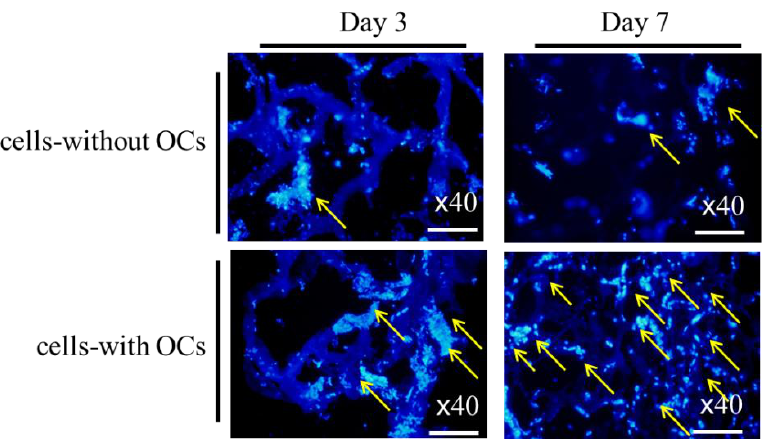
Figure 6. OC-embedded cells were visualized using DAPI staining and 3D fluorescence microscopy.